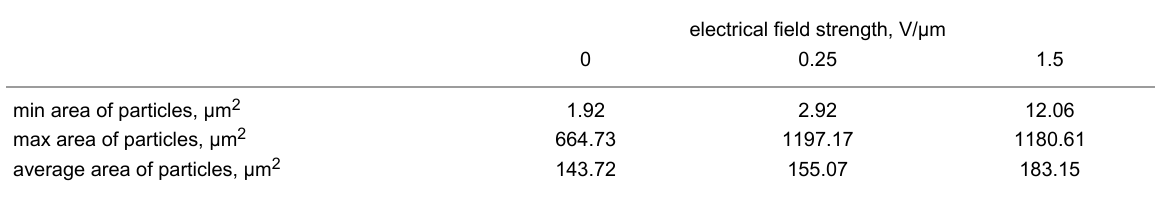
Table 1: The QD size distribution in the active LC matrix.